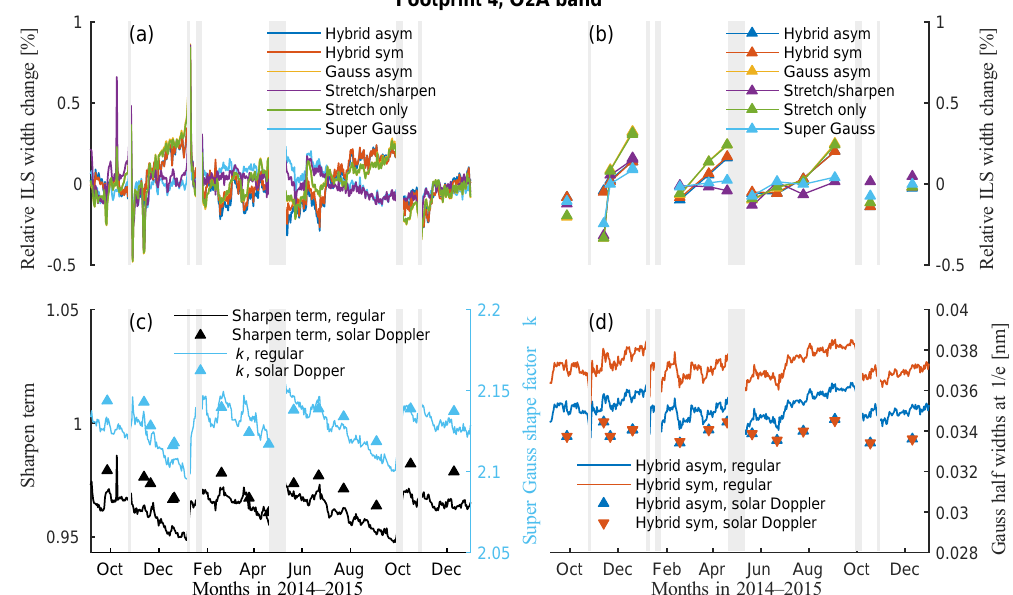
Figure 13. (a) Relative variations of derived ILS width from regular solar spectra using six fitting methods at footprint 4 of O2A band. The ILS widths are represented by full width at 1 /e for super Gaussian and FWHM for the other fitting methods. The ILS widths are also normalized by their medians and subtracted by unity. (b) Similar to (a) but using solar Doppler spectra. (c) Left vertical axis: sharpening term in the stretch/sharpen fitting, using both regular and solar Doppler spectra. Right vertical axis: the shape factor k in the super-Gaussian fitting, using both regular and solar Doppler spectra. (d) Half widths at 1 /e of the standard Gaussian component derived using hybrid asymmetric–symmetric function fitting, using both regular and solar Doppler spectra. The gray bands show the decon